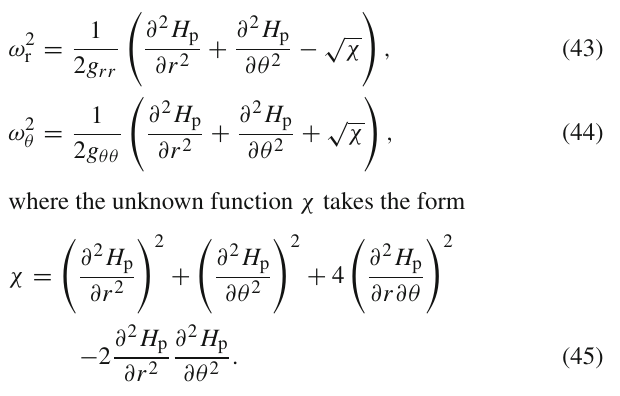
Fig. 13 PSs for particlesfrom ionized Keplerian disk, see Fig. 12. Two upperplotscorrespondtotrajectorieswithoutRR:theleftone( B = 0 . 1) consists from regular trajectories forming closed loops, while the right one ( B = 2) from chaotic trajectories, where the points are distributed apparently randomly; the grey dotted vertical lines show the inISCO